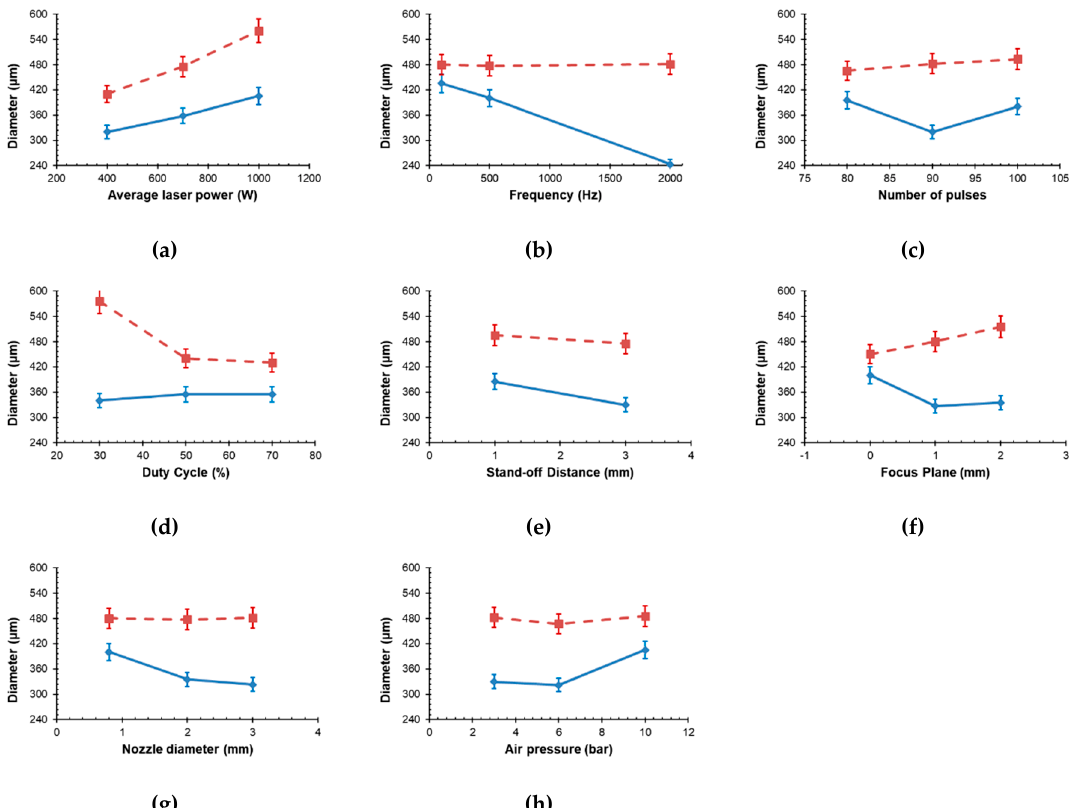
Figure 2. Main effects plots showing the influence of the processing parameters: ( a ) laser power; ( b ) frequency; ( c ) number of pulses; ( d ) duty cycle; ( e ) stand-off distance; ( f ) focus position; ( g ) nozzle diameter; ( h ) gas pressure on the entrance (dotted line) and exit (continuous line) diameters.